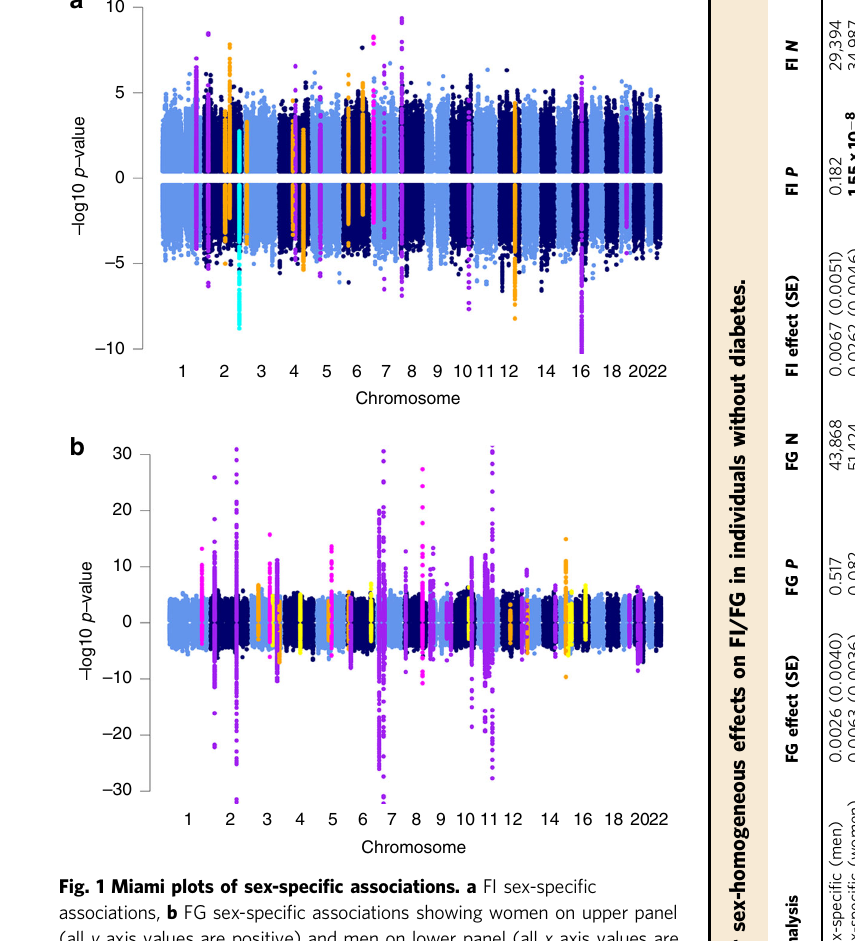
already known to be associated with the trait and located more than 500 kb away from any previously reported lead SNP (Fig. 1). We detected a sex-dimorphic effect on higher FI levels within the = 4.5 × 10 − 8 ), fi rst intron of ZNF12 at rs7798471-C ( P sex-dimorphic which has not been previously associated with any glycemic or other metabolic trait. We observed nominal evidence of sex heterogeneity ( P heterogeneity = 0.0046) with detectable effects only in women ( β female = 0.026, P female = 1.5 × 10 − 8 ; β male = 0.007, P male = 0.18) (Table 1 and Fig. 2a, b). The sex-combined analysis at the same variant did not reach genome-wide signi fi cance ( P sex- combined = 2.4 × 10 − 7 ) (Supplementary Data 4). This signal was not associated with T2D ( P > 0.05) 20 , but was previously nominally associated in the same direction with FI 21 . In addition, a proxy variant on Metabochip (rs3801033, r 2 EUR = 0.87 with rs7798471) was nominally associated with FI 22 in a previous sex- combined meta-analysis. Furthermore, the FI increasing allele (C) at rs7798471 was previously associated with higher body-mass index (BMI) in GIANT UK Biobank GWAS with stronger effects